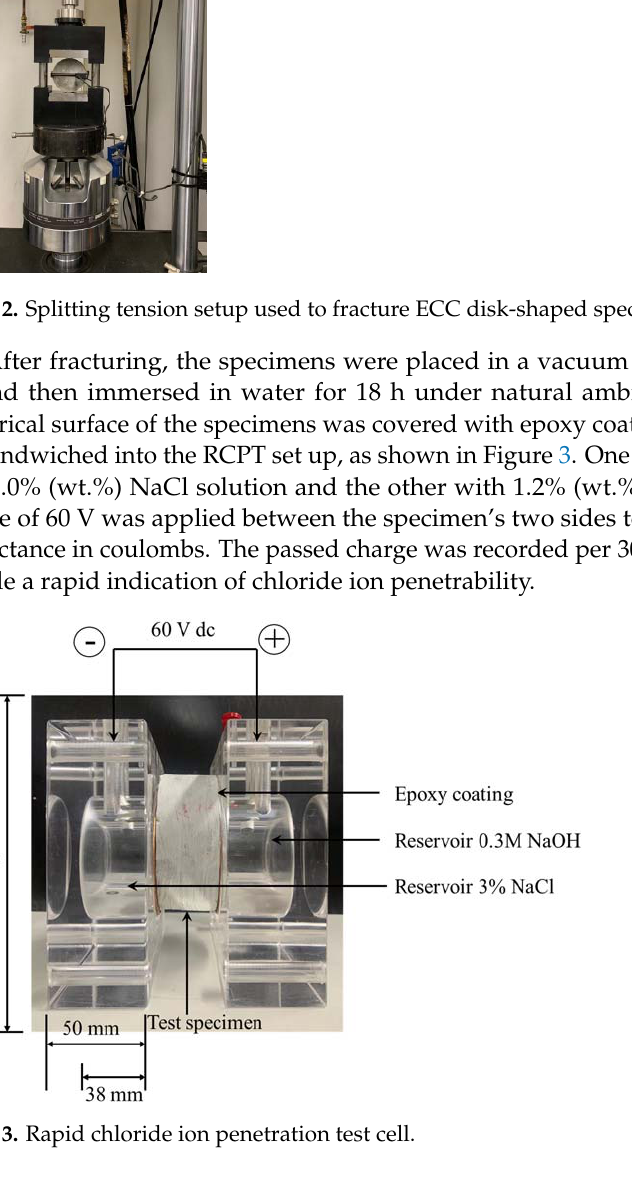
Figure 3. Rapid chloride ion penetration test cell. After the rapid chloride penetrability test, the specimens were split to measure the penetration of chlorides by using the colorimetric method. A silver nitrate aqueous solution (0.1 mol/L AgNO 3 ) was sprayed on one split surface of the specimens to reveal the depth of chloride penetration ( X d ). The chloride diffusion coefficient ( D ) under non-steady-state migration was calculated from X d according to the Bassuoni et al. [24] and Edvardsen et al. [25] via Equation (1):